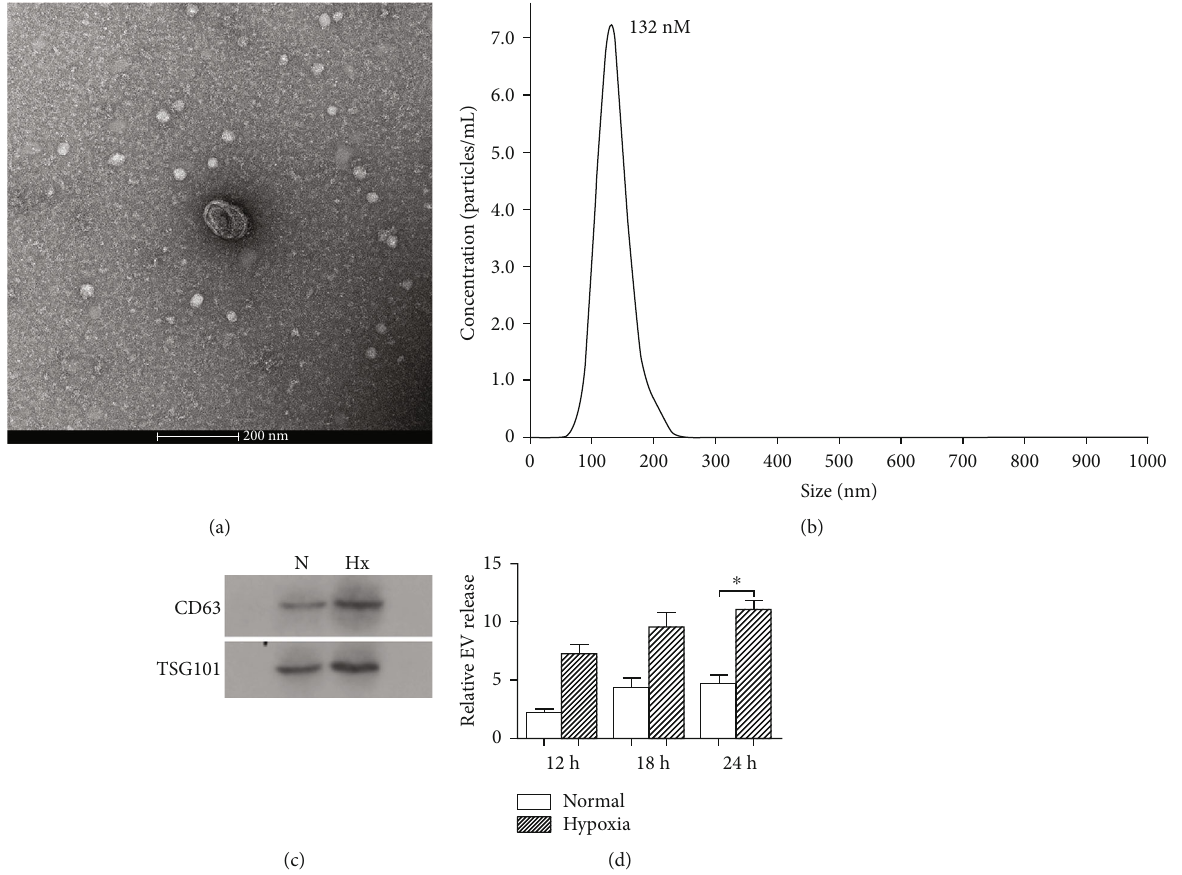
Figure 1: Characterization and quanti fi cation of exosomes produced by KEL cells under hypoxia or normoxic condition. KEL cells were incubated under hypoxic or normoxic condition for 12 h, 18h, or 24h to collect exosomes. (a) Representative electron micrograph of exosomes isolated from hypoxia- or normoxia-conditioned medium of KEL cells. Scale bar, 200 nm. (b) A representative plot showing the size distribution of exosomes was carried out using nanoparticle tracking analysis (NAT). (c) Western blot analysis showing the presence of CD63 and TSG101 in exosomes derived from KEL cells. (d) Quanti fi cation of exosomes produced by KEL cells under hypoxia or normoxic condition at various time points (12 h, 18 h, and 24h). The measurements were done using the NTA system in triplicate, and data presented as fold change of the EV number. N: normoxic; Hx: hypoxic. ∗ P < 0 : 05